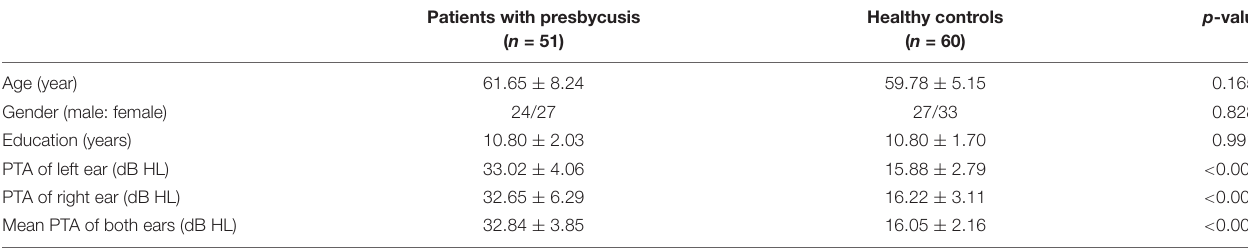
TABLE 1 | Demographics of patients with presbycusis and the healthy controls (HCs).